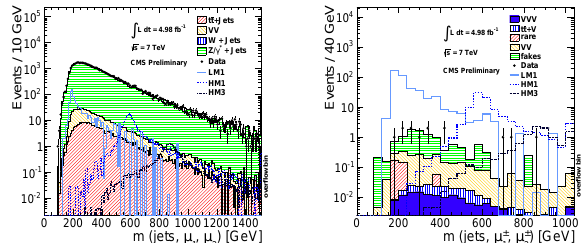
F igure 2. Invariant mass of the two muons and jets before (left) and after (right) applying the b-tag veto and same-sign muon re- quirement. Data are compared to the expectation from the sim- ulation (left) and measured backgrounds (right). Signal distribu- tions are shown for three di ff erent kinematic configurations for a = 0 . 01. coupling value of λ (cid:48) 211